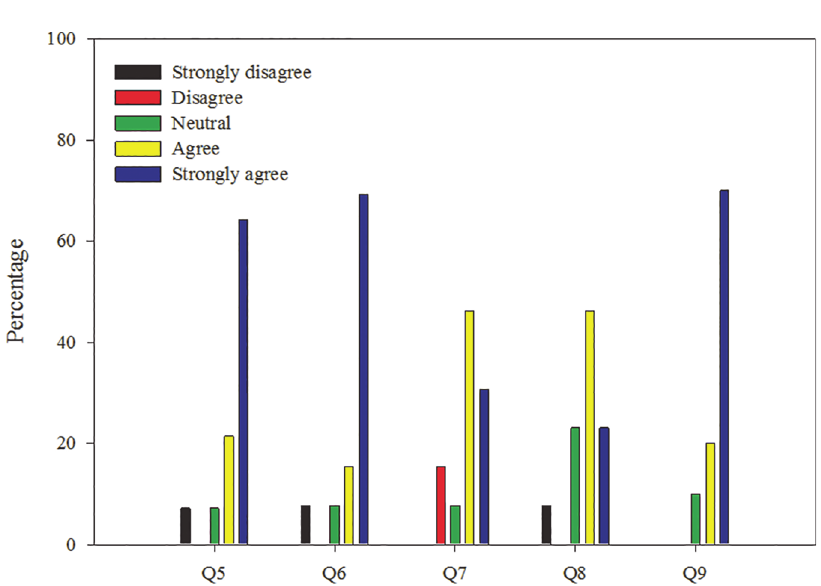
Fig 2. Participant written evaluation responses focused on the workshop environment. Q5: The workshop was well organized; Q6: The atmosphere of the workshop was professional; Q7: The lodging arrangements were clean and appropriate for this venue; Q8: The food selection was appropriate, on time, and enjoyable; Q9: Transportation during the workshop was on time, comfortable, and drivers were